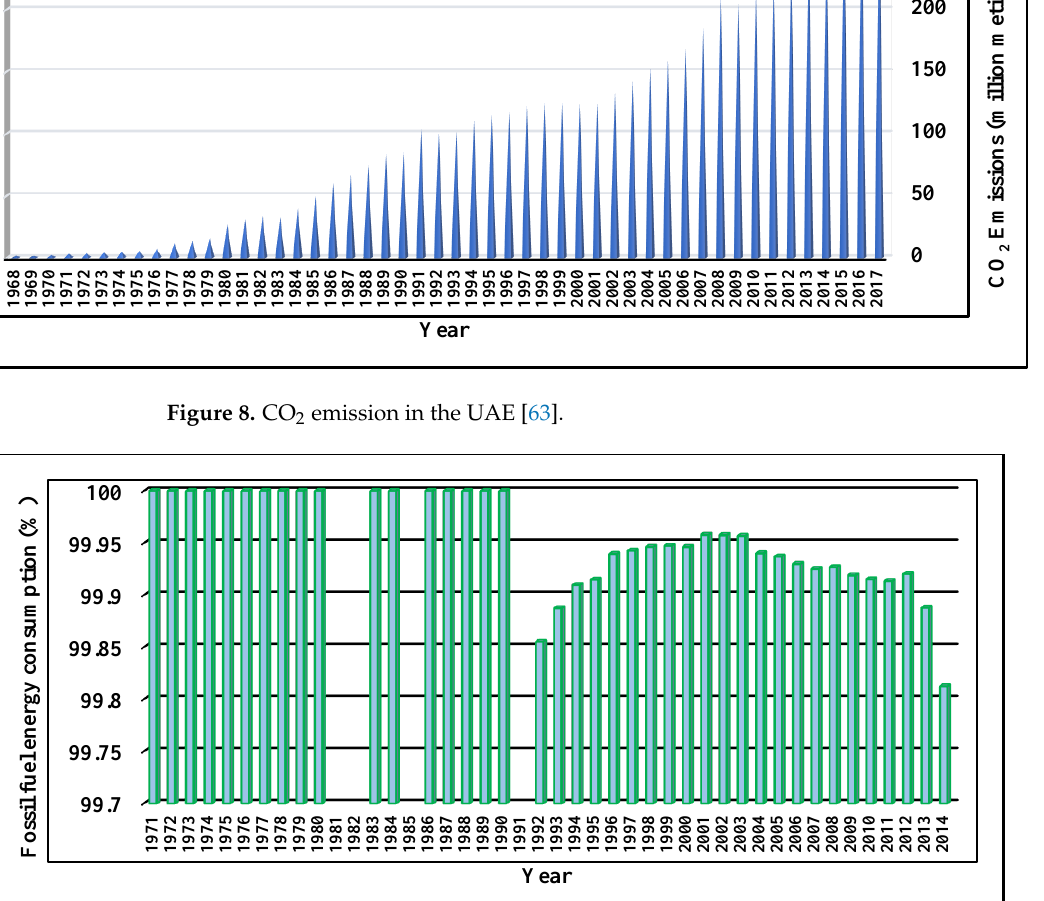
Figure 10. Referred growth rate of renewable energy capacity in the UAE. Reprinted with permis- sion from Ref. [64]. Figure 11. Renewable energy trends in the UAE (installed capacity in MW) [65]. Solar cell production used to be a challenge, owing to its low cost-effectiveness. Many studies have been conducted to minimize such production costs to produce better PV sys- tems [66]. Figure 12 depicts the pricing of solar PV modules in USD per watt from 2010 to